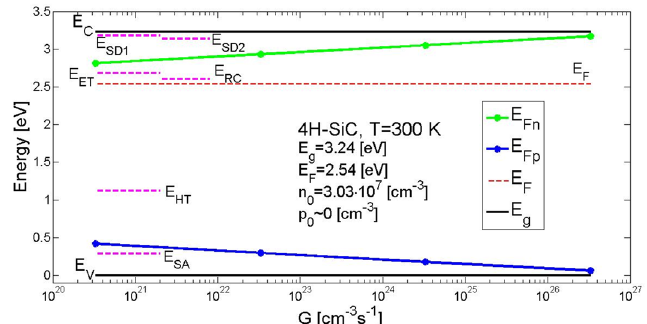
Figure 1. Energy levels in the band gap of SI 4H-SiC (at 300 K). They were assumed for solving the equations that describe rate of change in concentration of excess electrons and holes after a photo-induced generation of electron–hole pairs at rate of